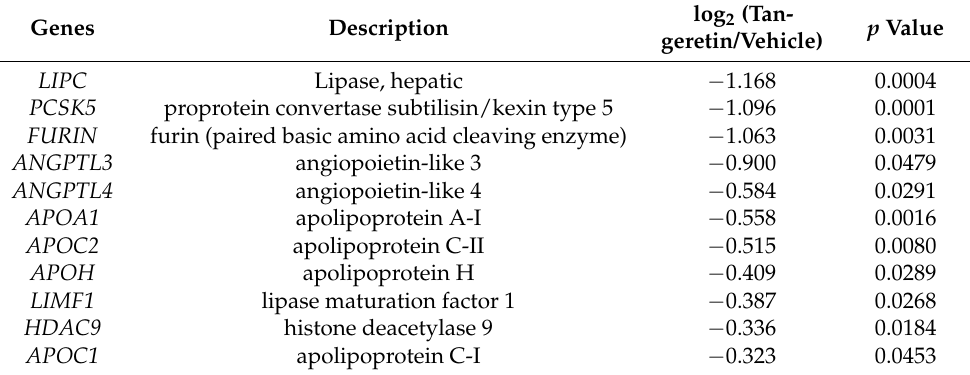
Figure 2. Enrichment analysis and visualization of Gene Ontology (GO) by REVIGO. Significantly enriched GO biological process (BP) in tangeretin (40 μM)-treated HepG2 cells was analyzed by REVIGO. The scatterplot indicates functional clusters; the bubble color and size represent the p -values and the frequency of the GO term in the underlying database, respectively. Table 1. The down-regulated genes associated with regulation of lipoprotein lipase activity in tangeretin-treated